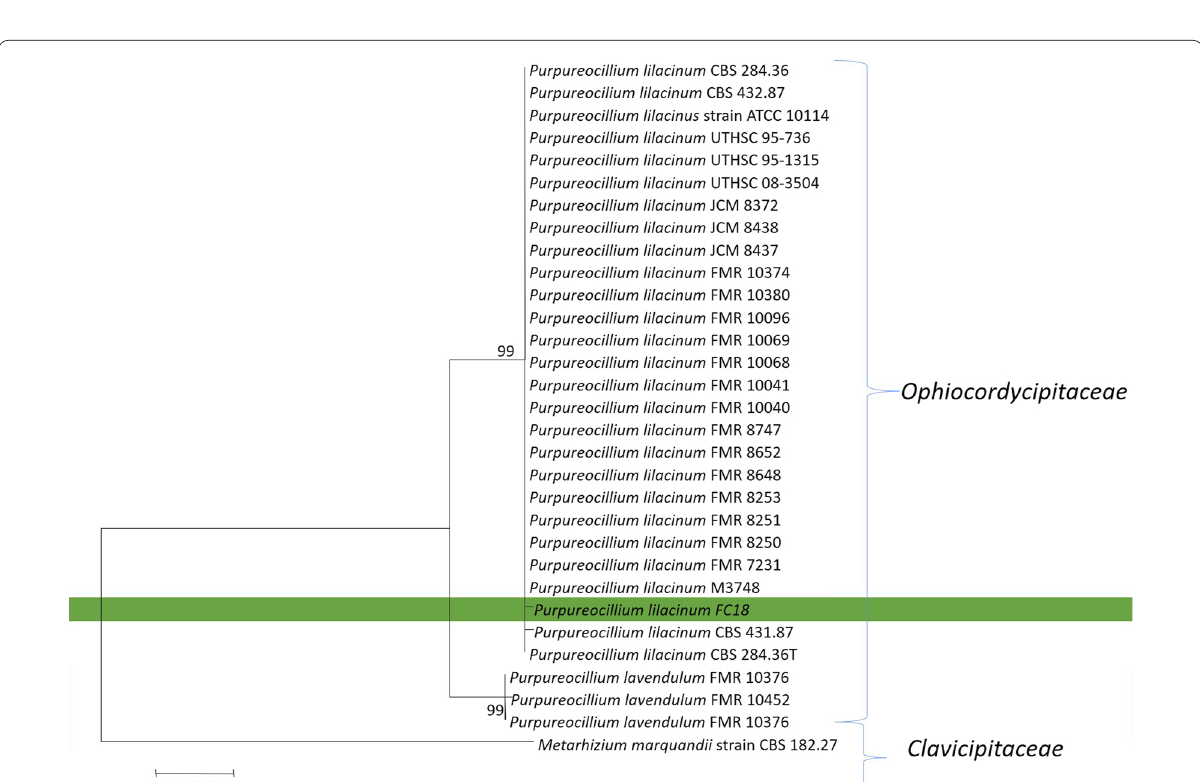
Fig. 3 Phylogenetic tree generated with maximum likelihood from concatenated ITS and LSU sequences of Purpureocillium lilacinum using Tamura 2-parameter model having 31 taxa and 917 characters. The numbers at the nodes indicate bootstrap percentages. The isolates retrieved in this study are in